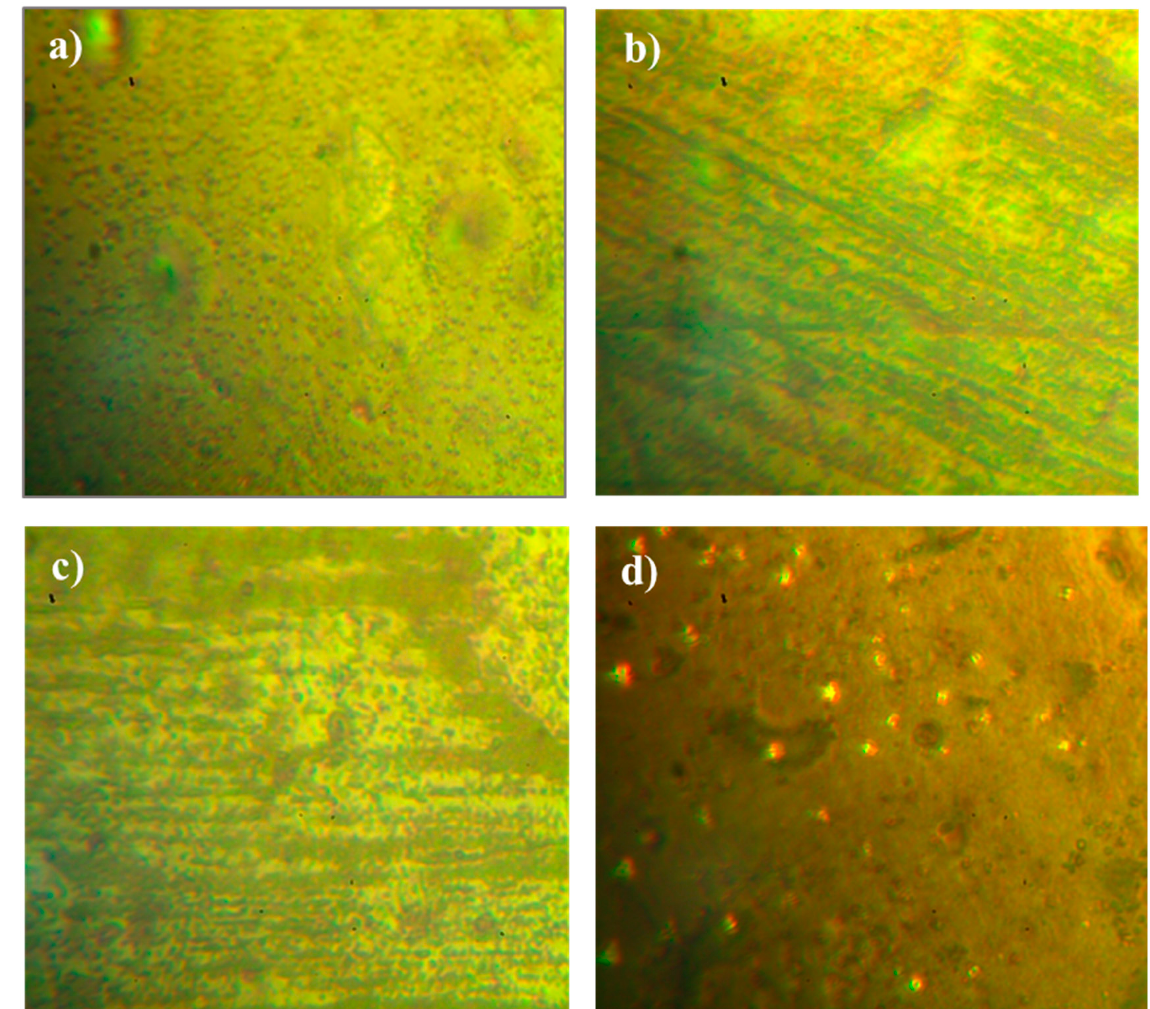
Figure 11. Microscopic image after irradiation of doped PVC with ( a ) PVC-ed/p-OH , ( b ) PVC-ed/o- OMe , ( c ) PVC-ed/p-OMe , ( d ) PVC-ed/o-NO 2 .